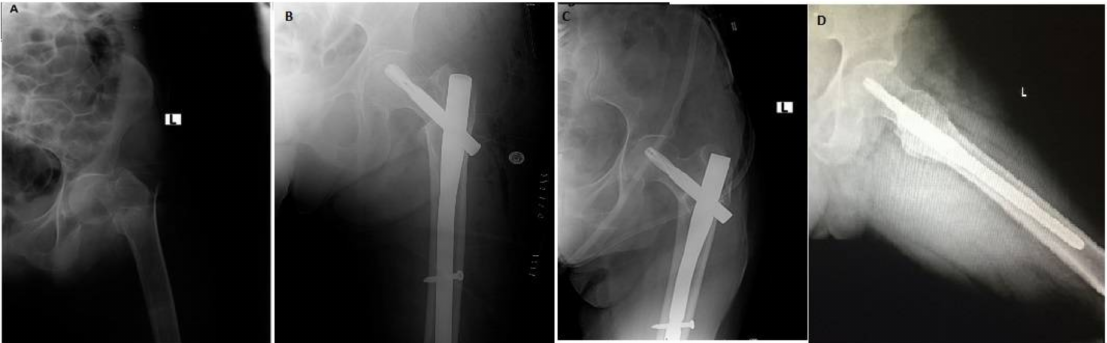
Figure 2. Type A3 fracture ( A ). Immediate postoperative AP radiograph showing a neck-shaft angle of 120 ◦ ( B ). 4 months follow up x-ray showing varus collapse with neck shaft angle of 115 ◦ ( C ).